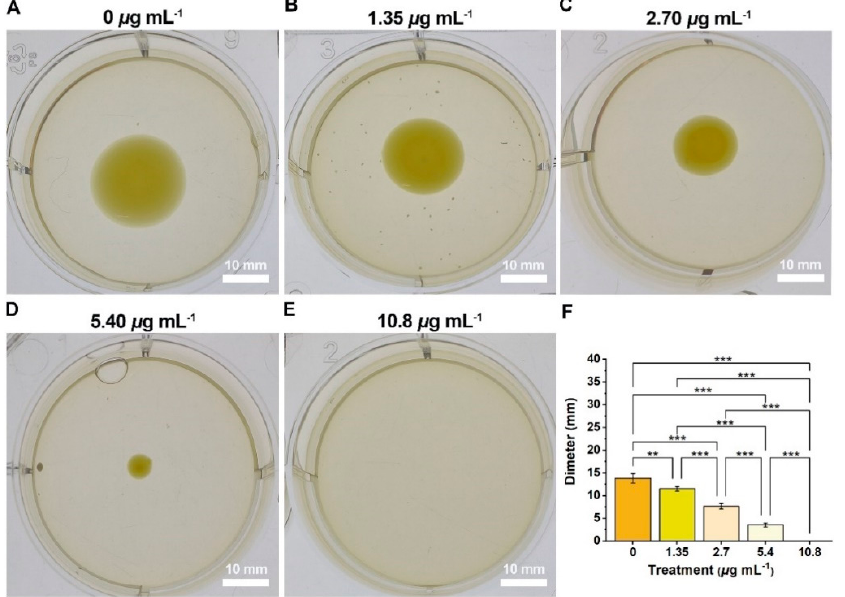
Figure 6. Compound 2b inhibited the swimming motility of Xanthomonas oryzae pv. oryzae at concentrations of 0 (A, served as blank), 1.35 (B), 2.70 (C), 5.40 (D), and 10.8 (E) μ g mL − 1 , and the swimming diameters were presented in (F).[(**) p < 0.01, (***) p < 0.001 vs. 0]. Scale bars are 10 mm.